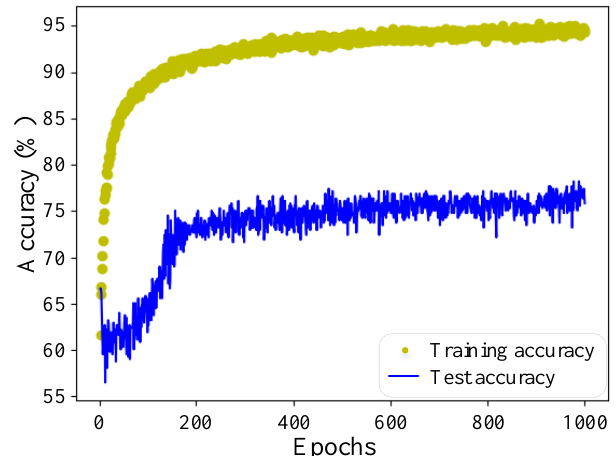
Figure 7. FLS model accuracy using a one-step training strategy.